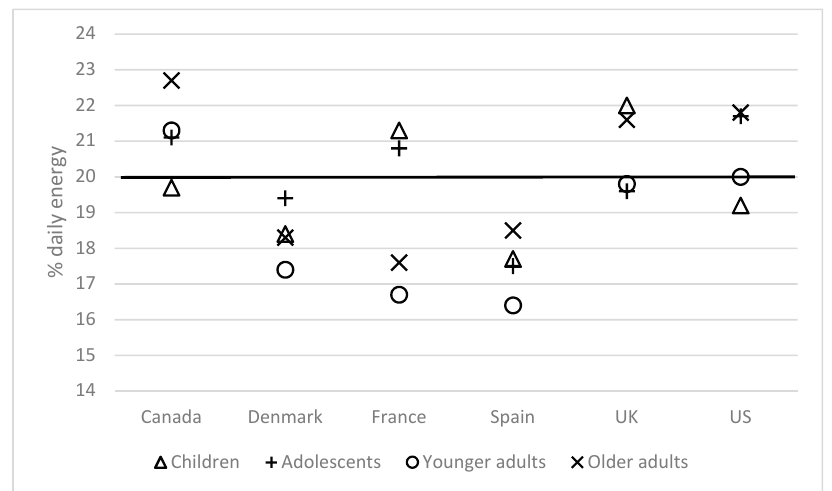
Figure 2. Contribution of breakfast to daily energy among regular breakfast consumers, by country and age group Age groups were defined as follows: Children (6–12 years, except Spain 9–12 years and UK 5–12 years); Adolescents (13–17 years, except UK 13–18 years); Younger adults (18–54 years, except UK 18–64 years); Older adults (55+ years, except UK 65+